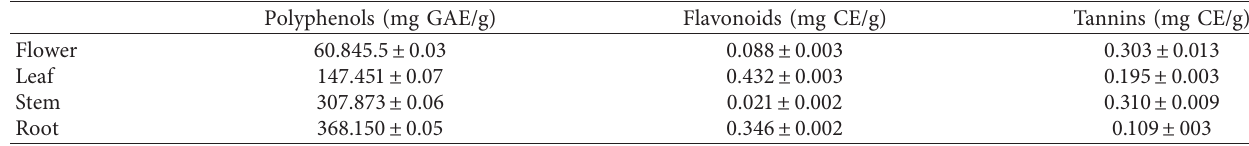
Table 2: Polyphenol, flavonoid, and tannin contents of Lobularia maritima organs.